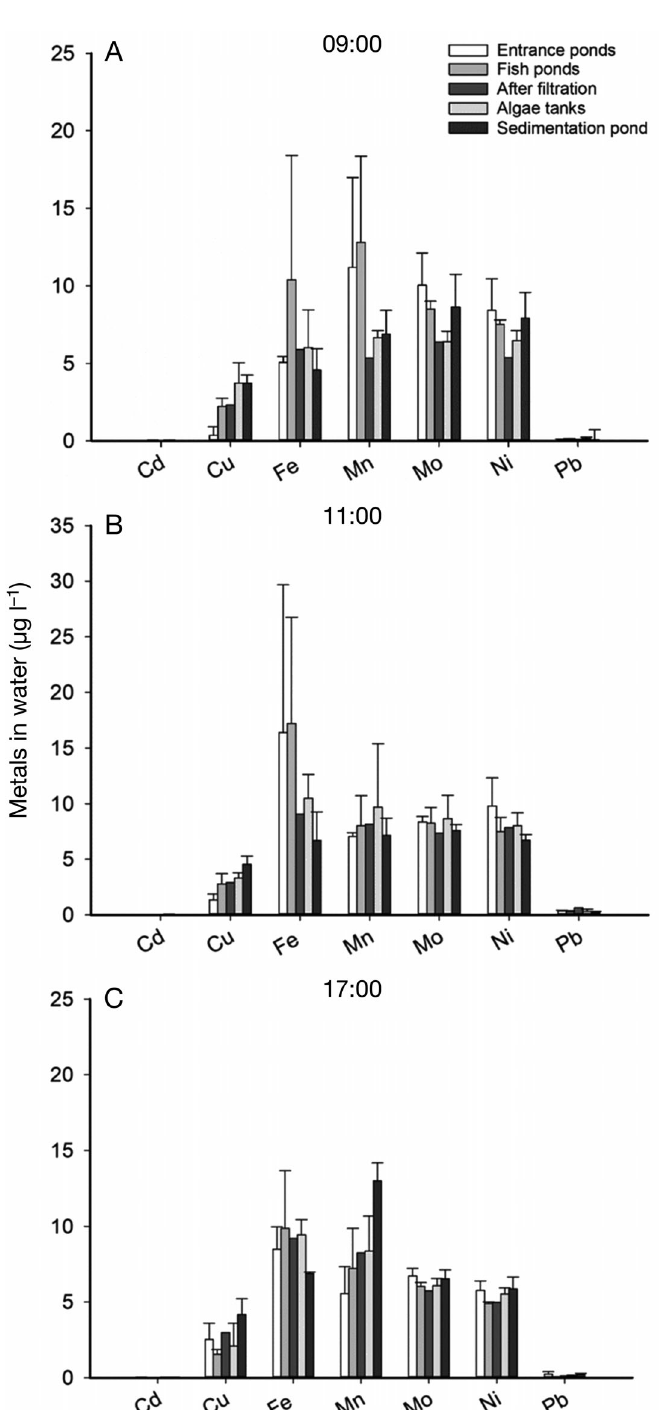
Fig. 6. Changes in heavy metal contents in seawater at the sampling site of the IMTA. Values display the average of metal concentrations in seawater of the ponds at the en- trance, the fish ponds, the algae tank, and the sediment pond at (A) 9:00 h, (B) 11:00 h and (C) 17:00 h. Data were analysed using a Kruskal-Wallis test followed by a multiple comparisons with Dunn’s test indicating no significant differences between the ponds. Error bars: SD (n =